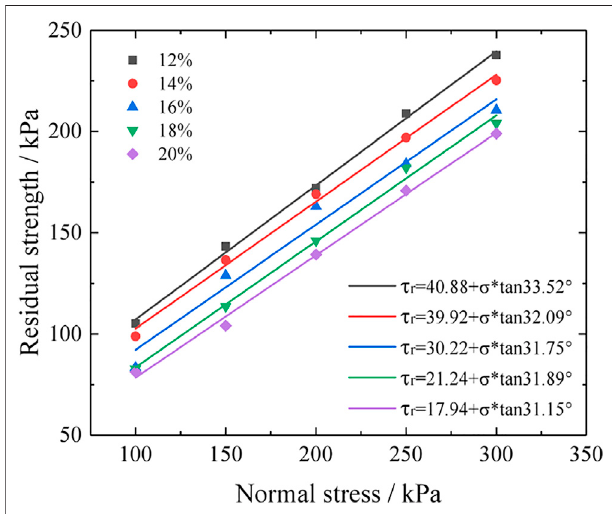
FIGURE 8 | Changes in residual strength values of specimens with different moisture content.